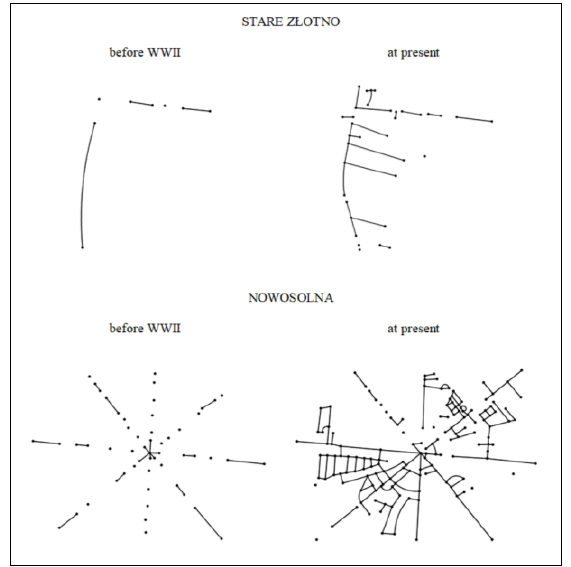
Fig. 6. Graphs depicting the average rank of morphological changes of the former villages Stare Złotno and Nowosolna (in the intra-urban area) (Source: own work)